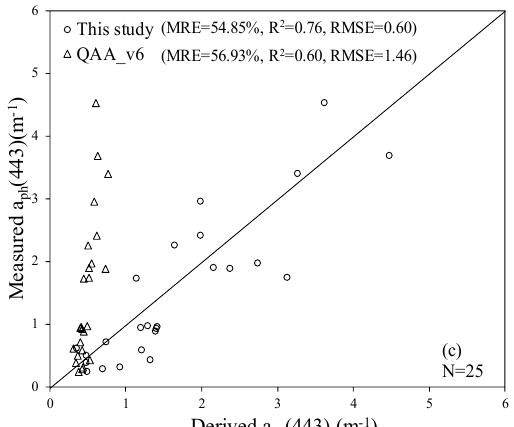
Figure 13. Comparison of measured and derived total absorption coe ffi cients at ( a ) 443 nm and ( b ) 555 nm, and a ph at ( c ) 443 nm for applying the algorithm in this study and QAA_v6, respectively. Table 9. Accuracy assessment of the algorithm in this study and QAA_v6.